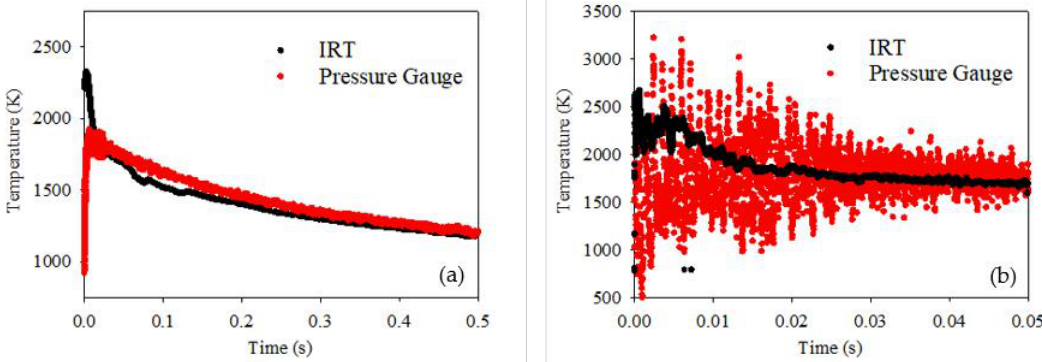
Figure 7. Temperature measurement of the confined blast for the ( a ) first 500 ms of the fireball, with